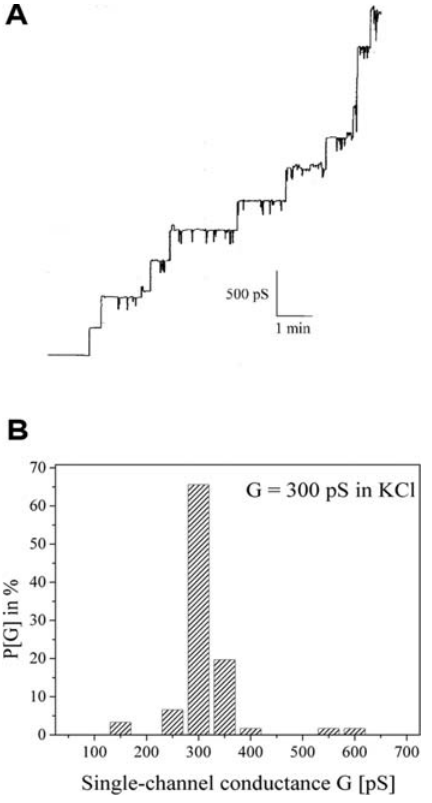
Figure 3. Channel-forming activities of FPLC purified BesC. (A) Single-channel recording of a diphytanoyl phosphatidylcholine/ n - decane membrane observed in the presence of 100 ng/ml of fraction 35 of the MonoQ-FPLC of the B-fraction of B. burgdorferi B31-A p66::str . The aqueous phase contained 1 M KCl; V m = 20 mV; T = 20 u C. (B) Histogram of the probability P(G) for the occurrence of a given conductivity unit observed with membranes formed of 1% diphytanoyl phosphatidylcholine/n-decane in the presence of fraction 35 of the MonoQ-FPLC of the B-fraction of B. burgdorferi B31-A p66::str . P(G) is the probability that a given conductance increment G is observed in the single-channel experiments. It was calculated by dividing the number of fluctuations with a given conductance increment by the total number of conductance fluctuations. The average single-channel conductance for 122 single-channel events was 300 pS.